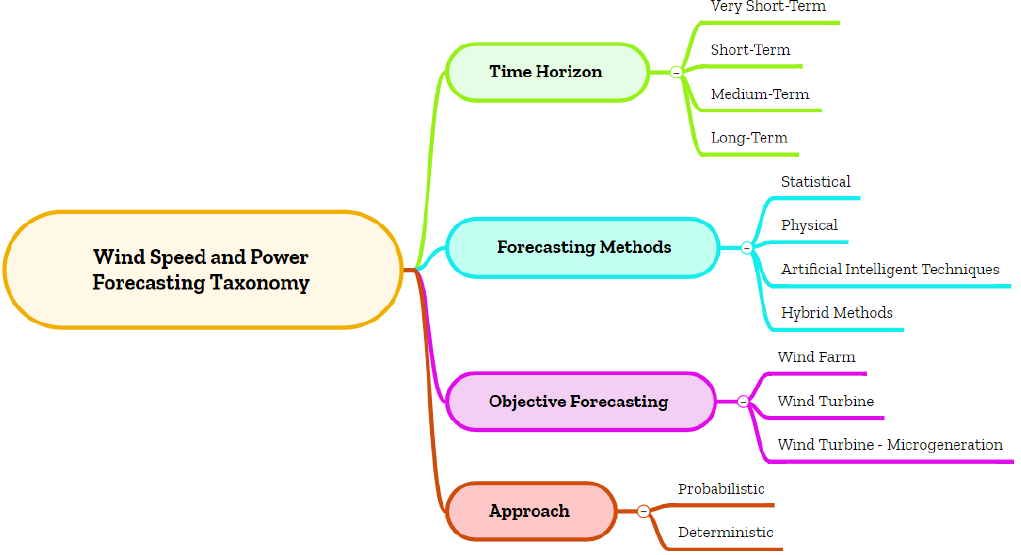
Figure 5. Wind-speed and -power forecasting taxonomy.